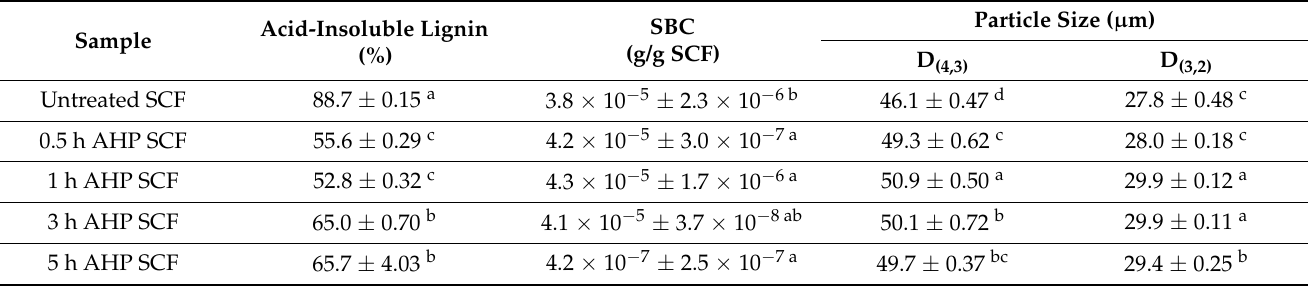
Table 2. Acid-insoluble lignin content, sugar binding capacity (SBC), particle size of untreated SCF and AHP SCF